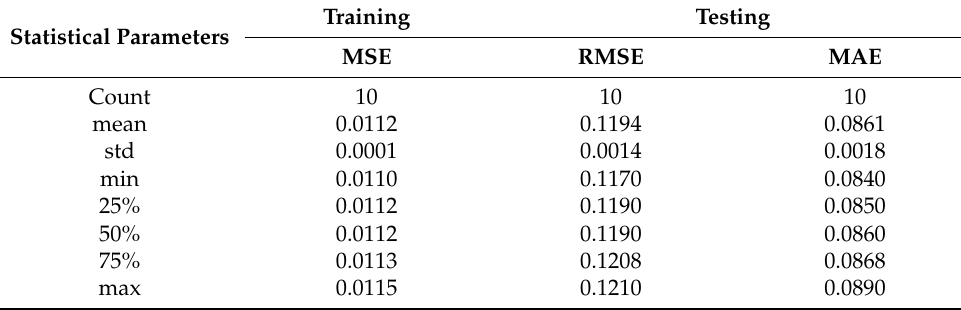
Table 10. Observations of performance of the RHM-2 in stochastic environment. Statistical